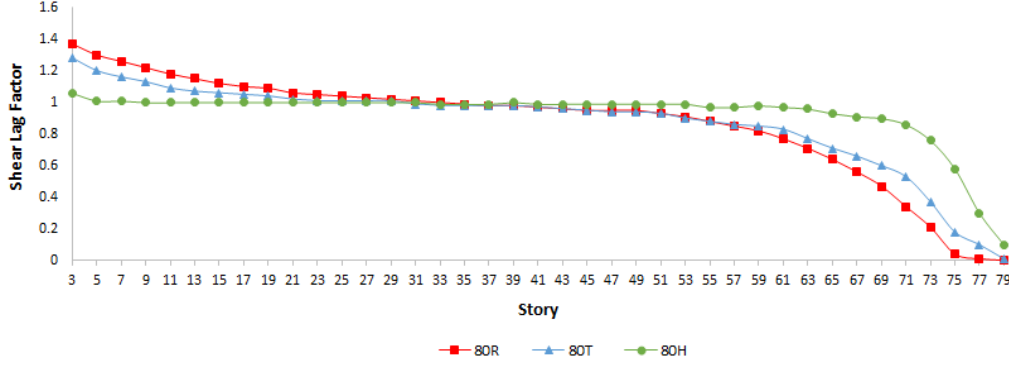
Figure 7. Shear lag factor diagram for 80 story structures subjected to the dynamic earthquake load.